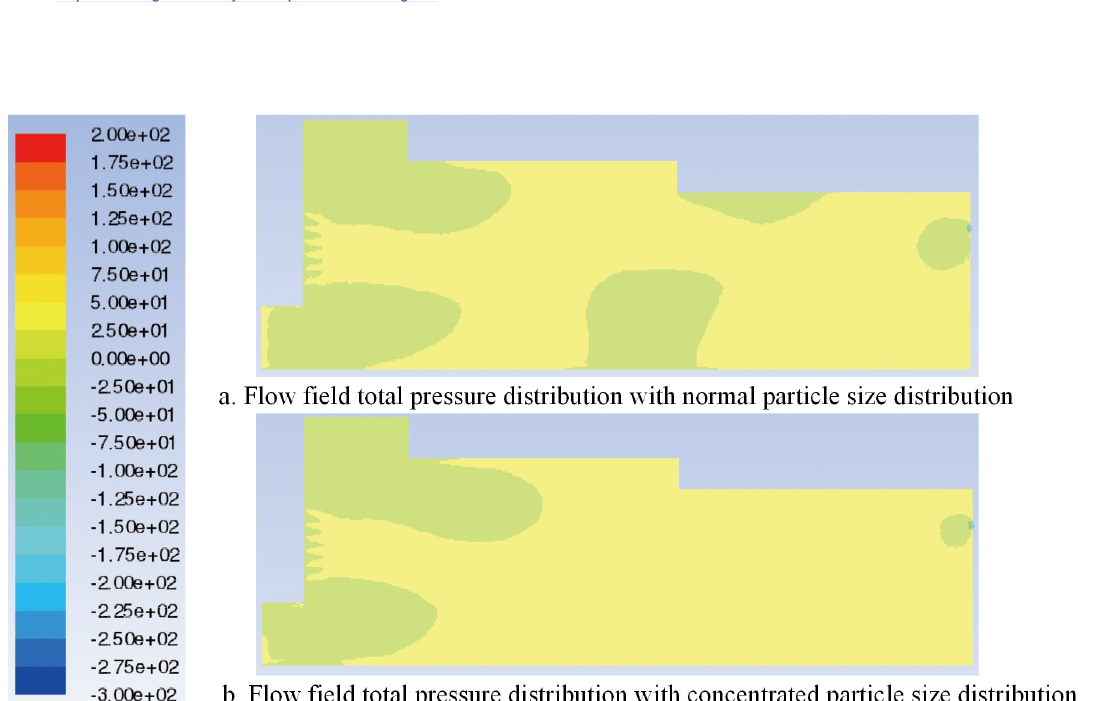
Fig 24. Flow field total pressure distribution with different particle sizes.